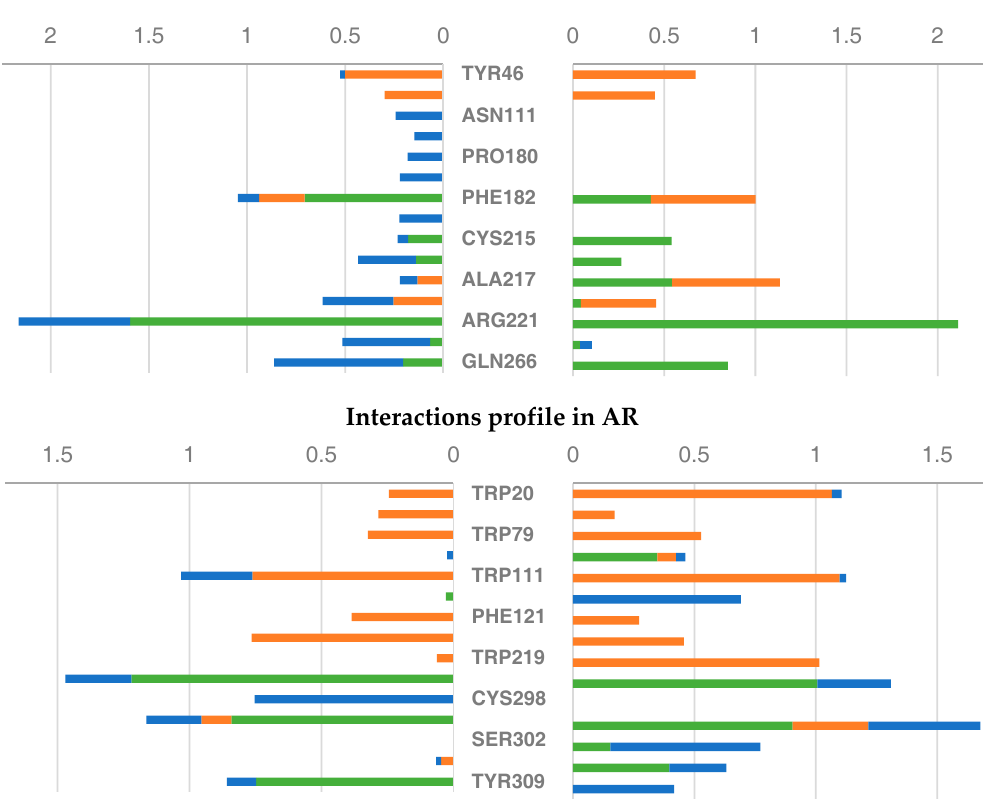
Figure 5. Protein–ligand interactions profile of Compounds 6 (left) and 9 (right) with PTP-1B and AR during the last 200 ns of simulation. The color of the bar represents the type of interaction (orange: hydrophobic; green: hydrogen-bond; blue: water-bridge). The fact that some residues can form more than one type of interaction allows the value to be larger than